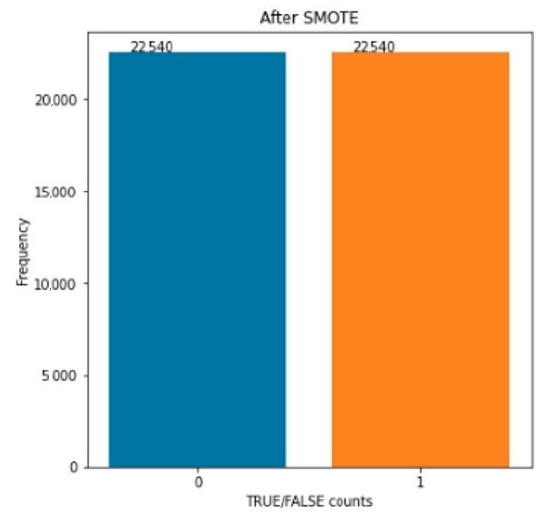
Figure 4. Data balancing after SMOTE.